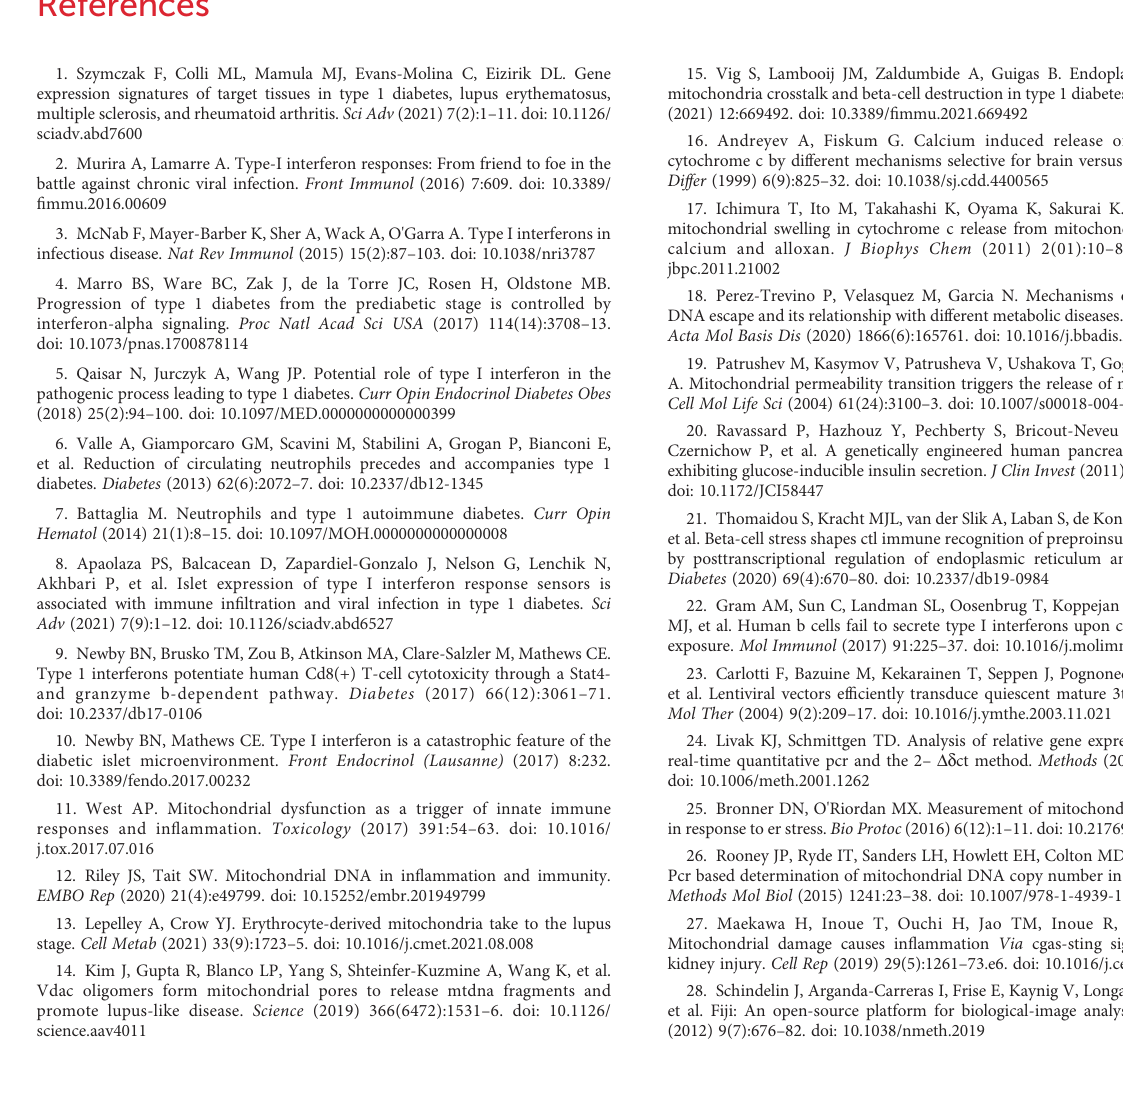
SUPPLEMENTARY FIGURE S1 (A) cGAS protein expression in EndoC- b H1 after exposure to TG (0,1µM for 24h). Expression of b -actin is used as loading control. (B) densitometric quanti fi cation of cGAS expression. Data are shown as average of 3 independent experiments and as relative intensity using b -actin as reference. SUPPLEMENTARY FIGURE S2 (A) MDA5 gene expression after MDA5 speci fi c siRNA transfection or scrambled siRNA transfection. (B) IFN b gene expression after MDA5 speci fi c siRNAtransfectionorscrambledsiRNAtransfection. (C) cGASgeneexpression after cGAS speci fi c shRNA transduction or control shRNA lentivirus transduction. (D) IFN b gene expression after cGAS speci fi c shRNA transduction or control shRNA lentivirus transduction. SUPPLEMENTARY FIGURE S3 TotalmtDNAamountdeterminedbyqPCRinEndoC- b H1cellsafterTGexposure. SUPPLEMENTARY FIGURE S4 Cytokine pro fi le expression determined by Luminex assay on primary islet supernatant after TG exposure (n=1 pancreas donor. The results are representative of 3 independent